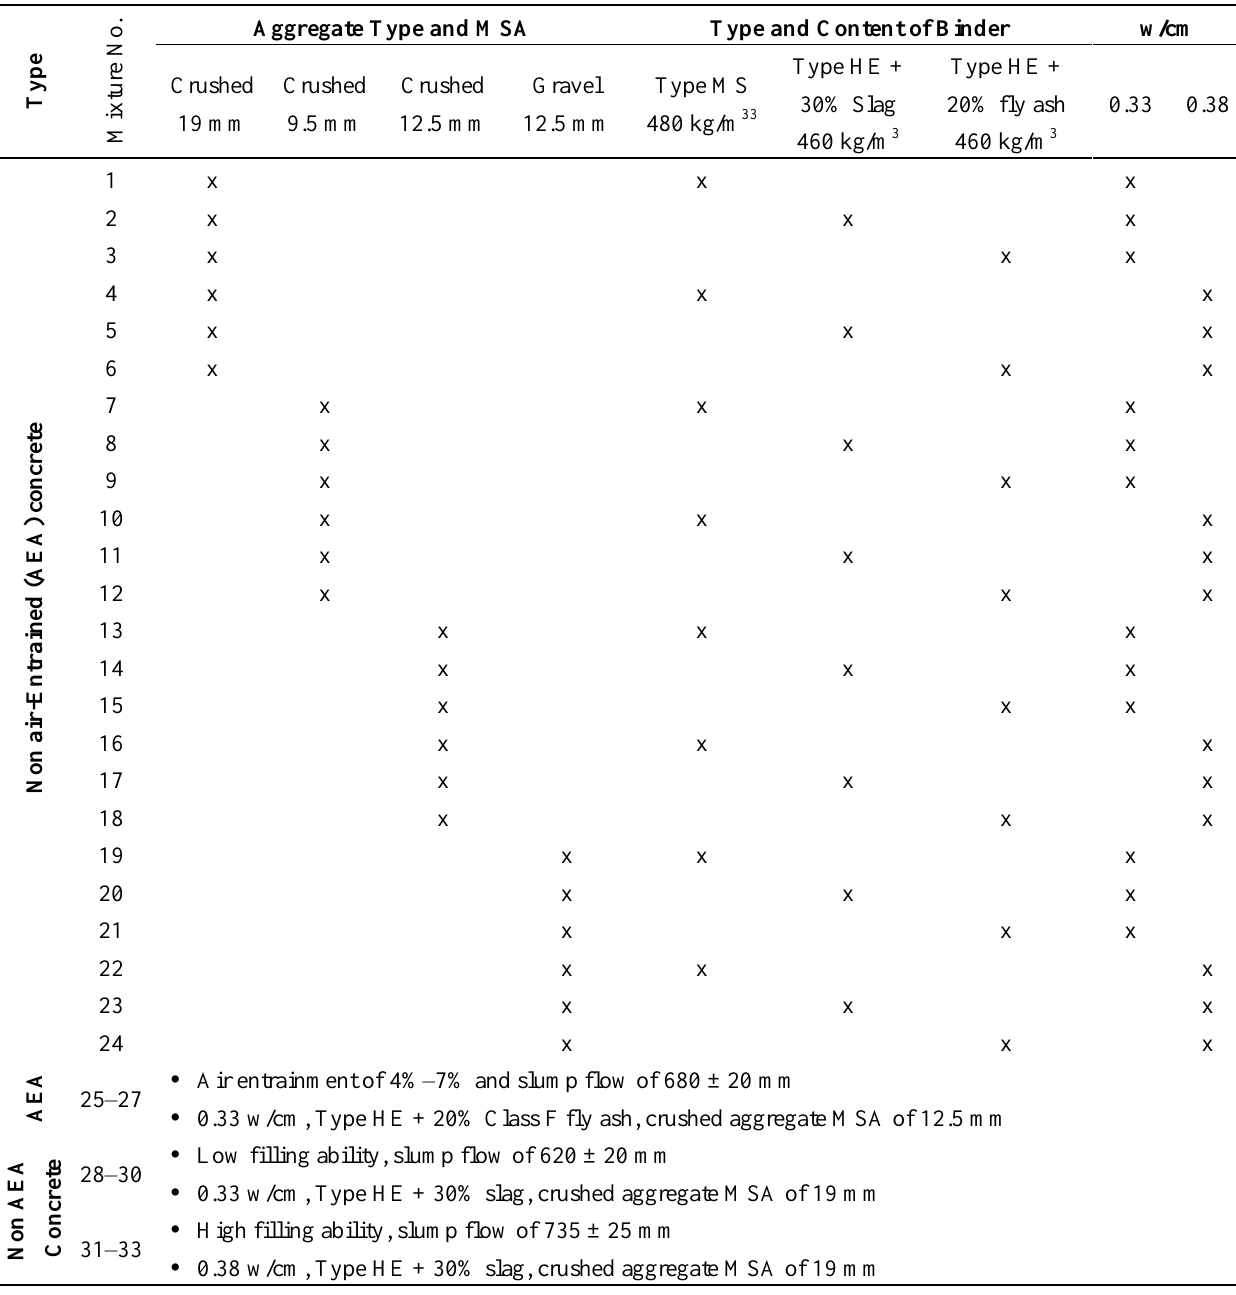
Table 4. Parametric experimental